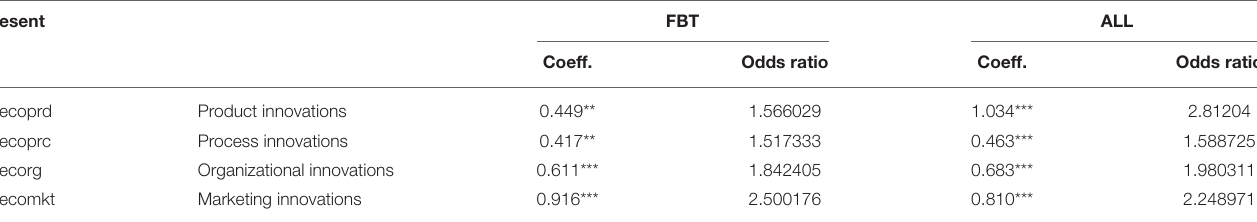
TABLE 11 | Ordered logit regression parameters of the circular advantages of innovation for end-users. esent